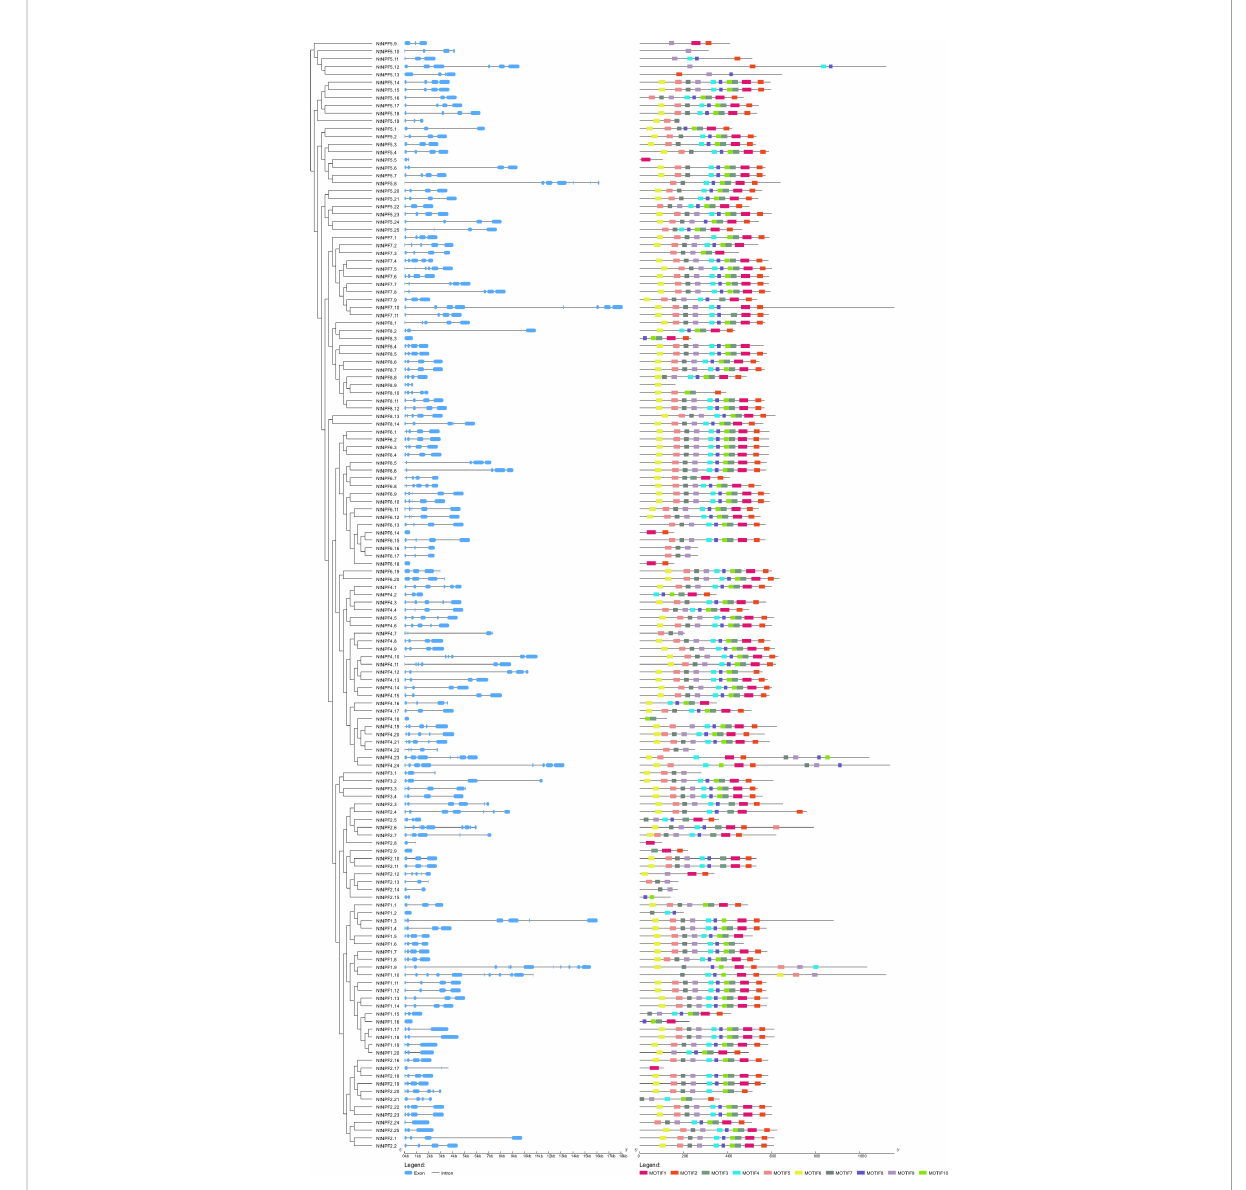
FIGURE 3 Phylogenetic relationships, gene structure, and architecture of conserved protein motifs of NtNPF genes in